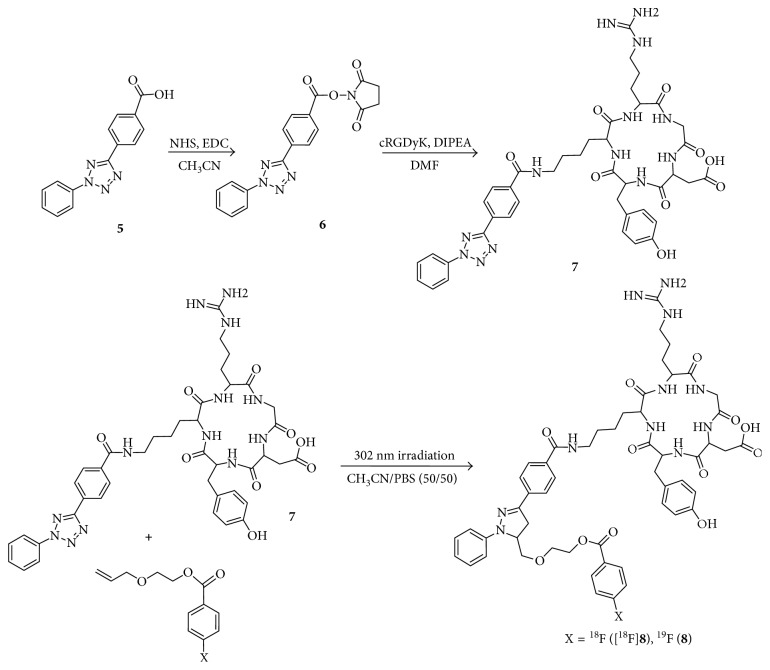
Synthesis of 18FB-PEGhc-RGD ([18F]8) and 8 using photoinducible click reaction.